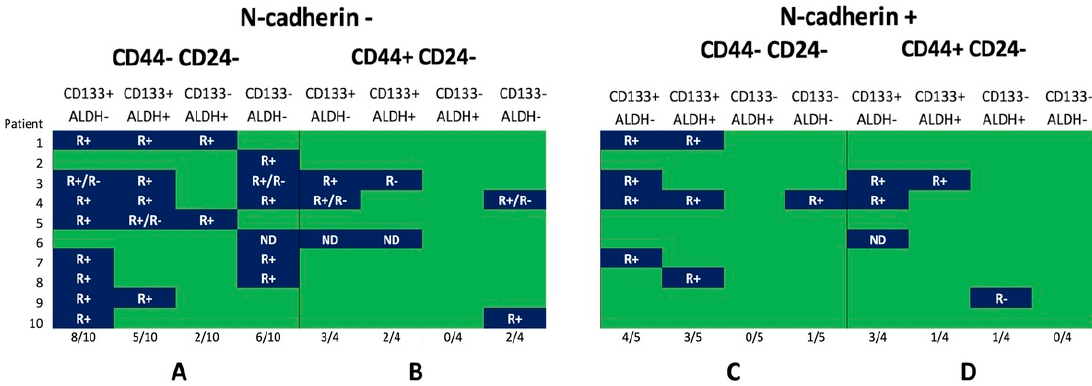
Figure 5. CTC profiles depended on N-cadherin expression and combination of stem markers in breast-cancer patients. Frequency of ( A ) nonstemlike CTCs without EMT features; ( B ) stemlike CTCs without EMT features; ( C ) nonstemlike CTCs with EMT features; and ( D ) stemlike CTCs with EMT features. R, CXCR4 and / or CXCR7 expression; ND, no data.